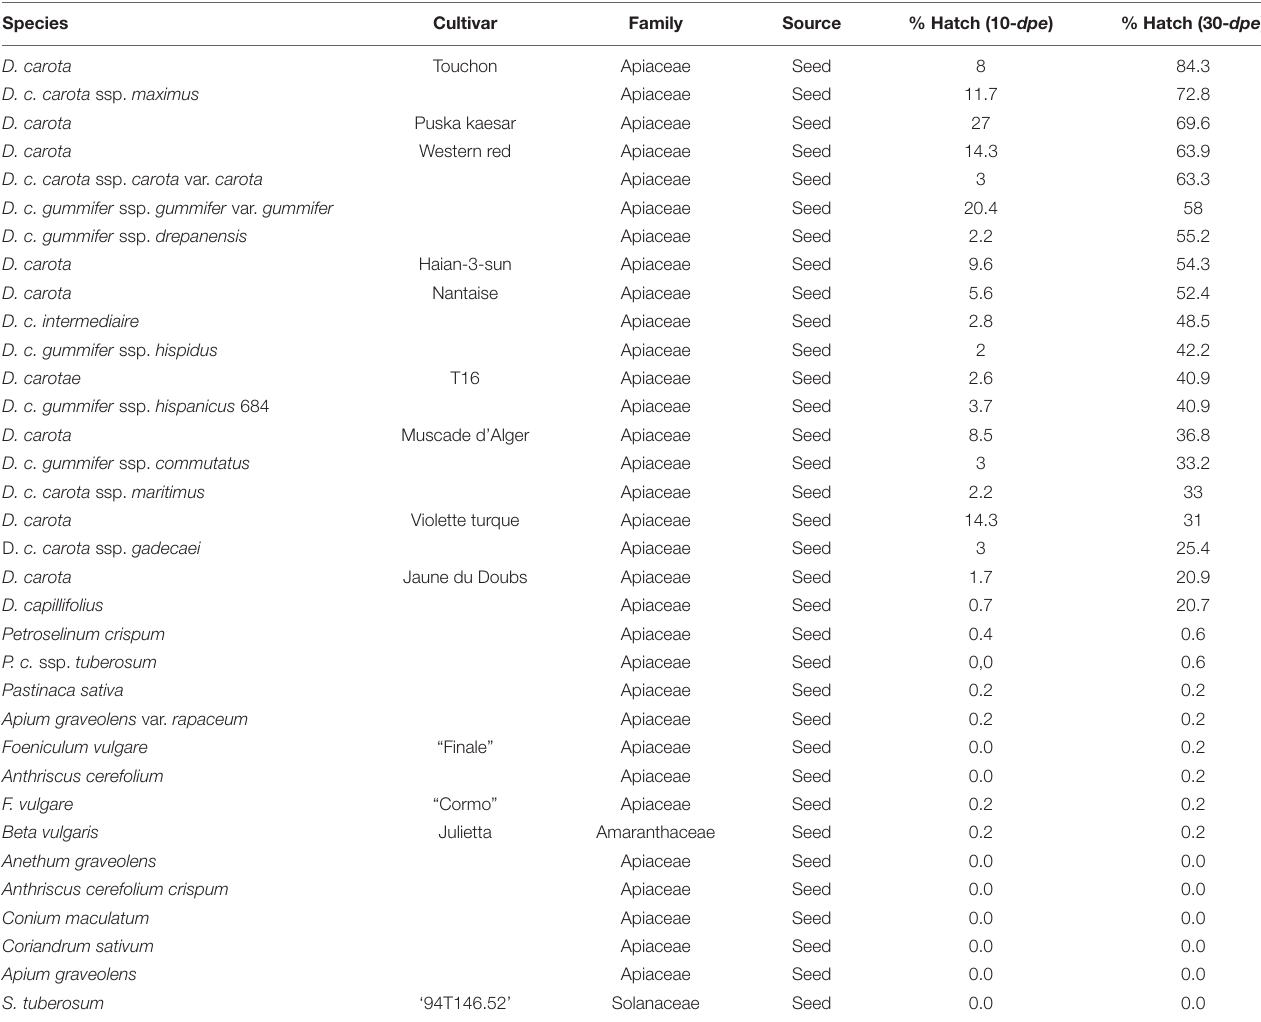
TABLE 1B | Plant species and/or cultivars screened for the ability of their root exudates to induce hatching of Heterodera carotae in vitro. Species Cultivar Family Source % Hatch (10- dpe ) % Hatch (30- dpe